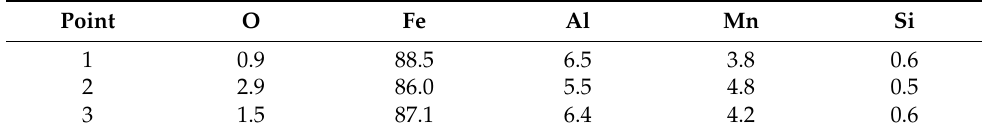
Table 5. 6Al-4Mn steel, results of EDS analysis after immersion in wt.%.